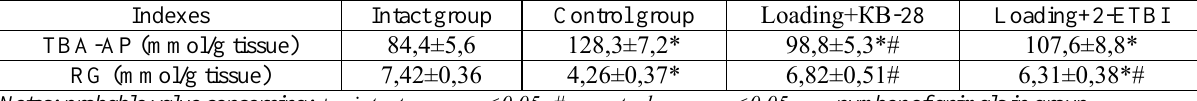
The influence of КВ-28 and 2-ETBI on the prooxidant-antioxidant balance under intense exercise (M±m, n=7) Indexes Intact